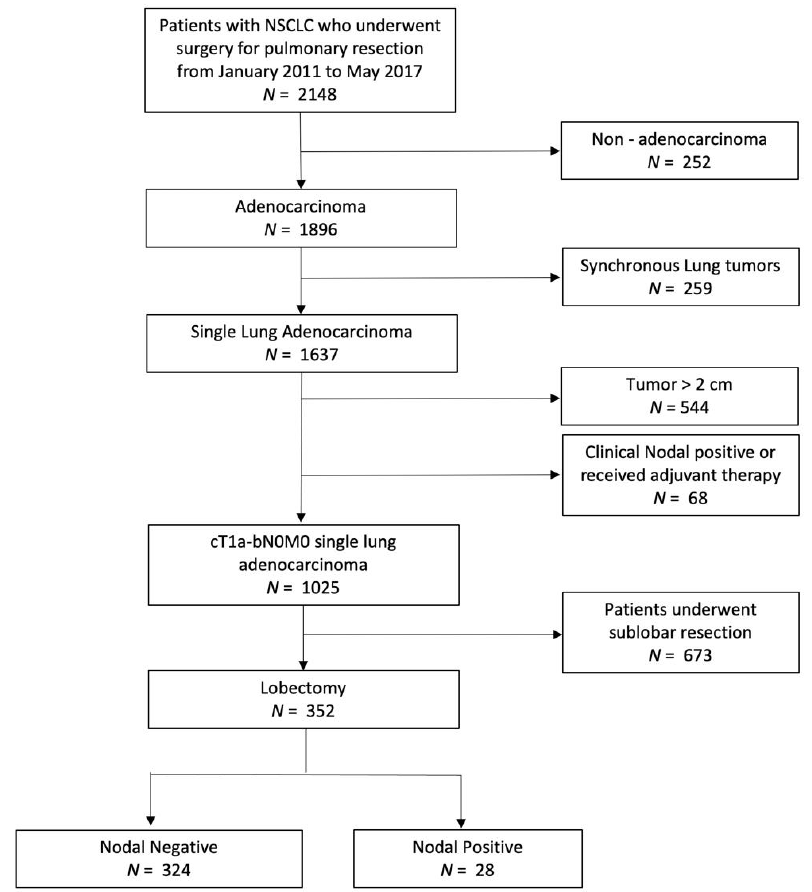
Figure 1. Algorithm for patient selection. NSCLC non-small cell lung cancer.